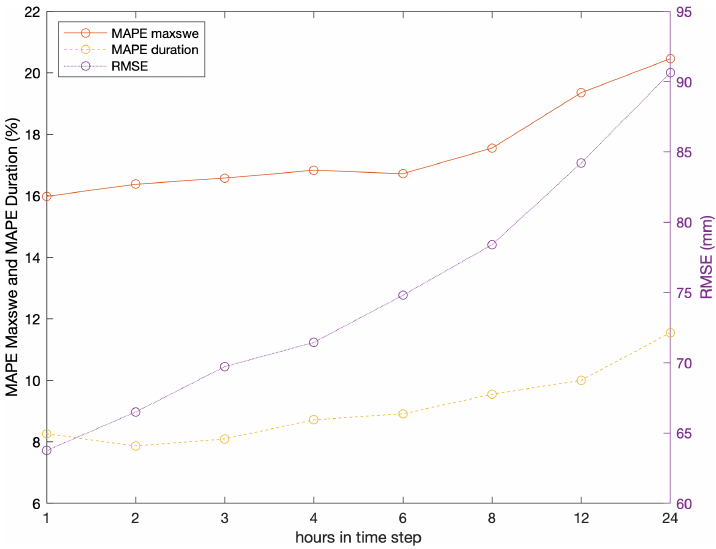
Figure B4. Performance of the snow model without shallow snow correction for different time steps using the parameter set selected in calibration of the hourly model with shallow snow correction. Points represent median values across 170 SNOTEL